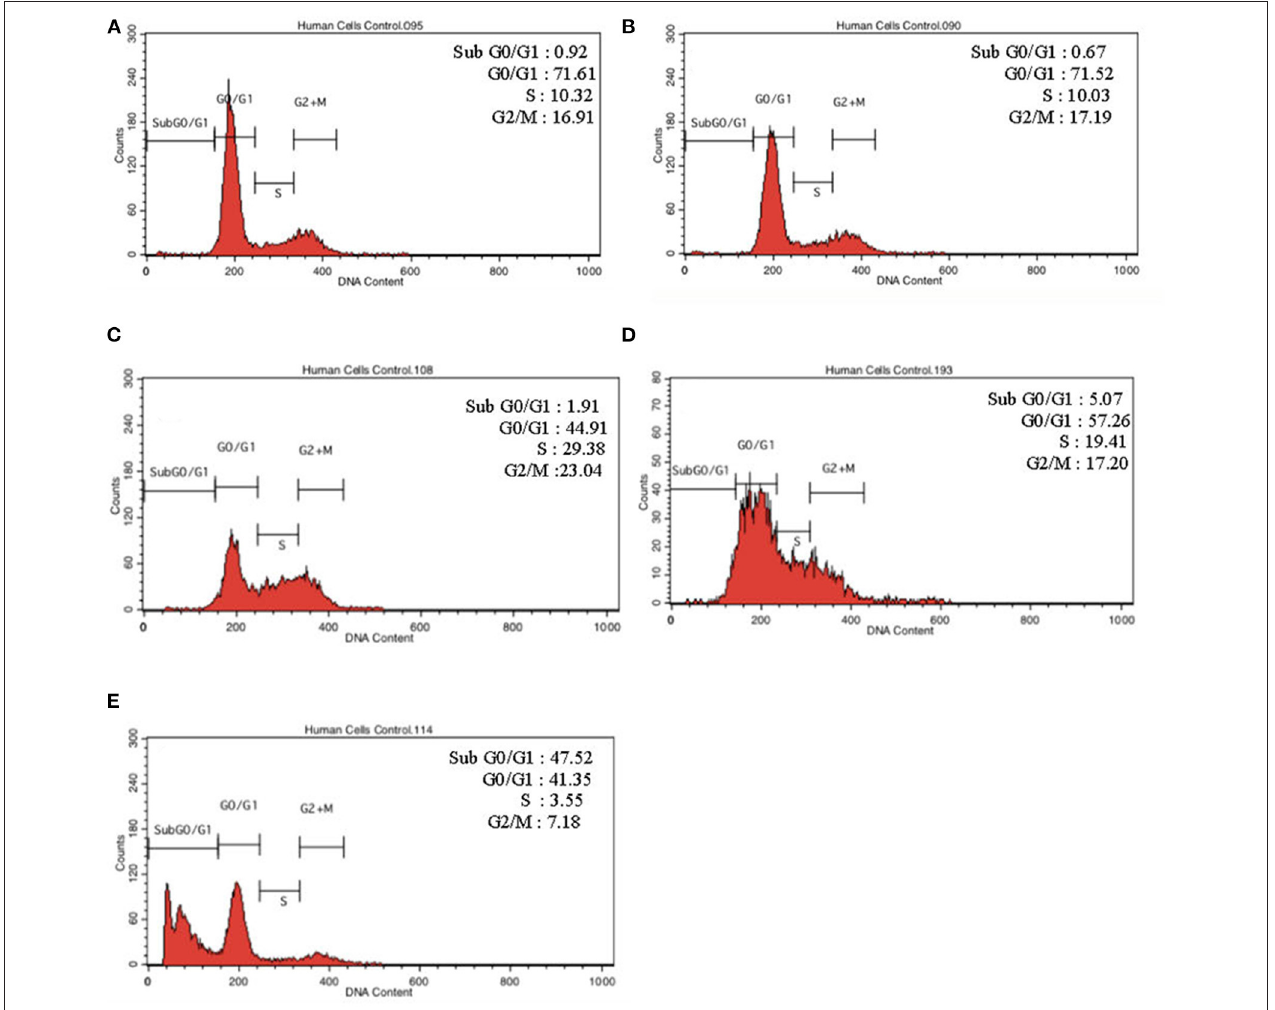
FIGURE 10 | Cell cycle distribution analysis in LPS-preconditioned cells by using flow cytometry. Cells were treated with 6 µ g/mL LPS for (A) . Control, (B) . 12, (C) . 24, (D) . 48, and (E) . 72h. Representative flow cytometry patterns from three independent experiments are